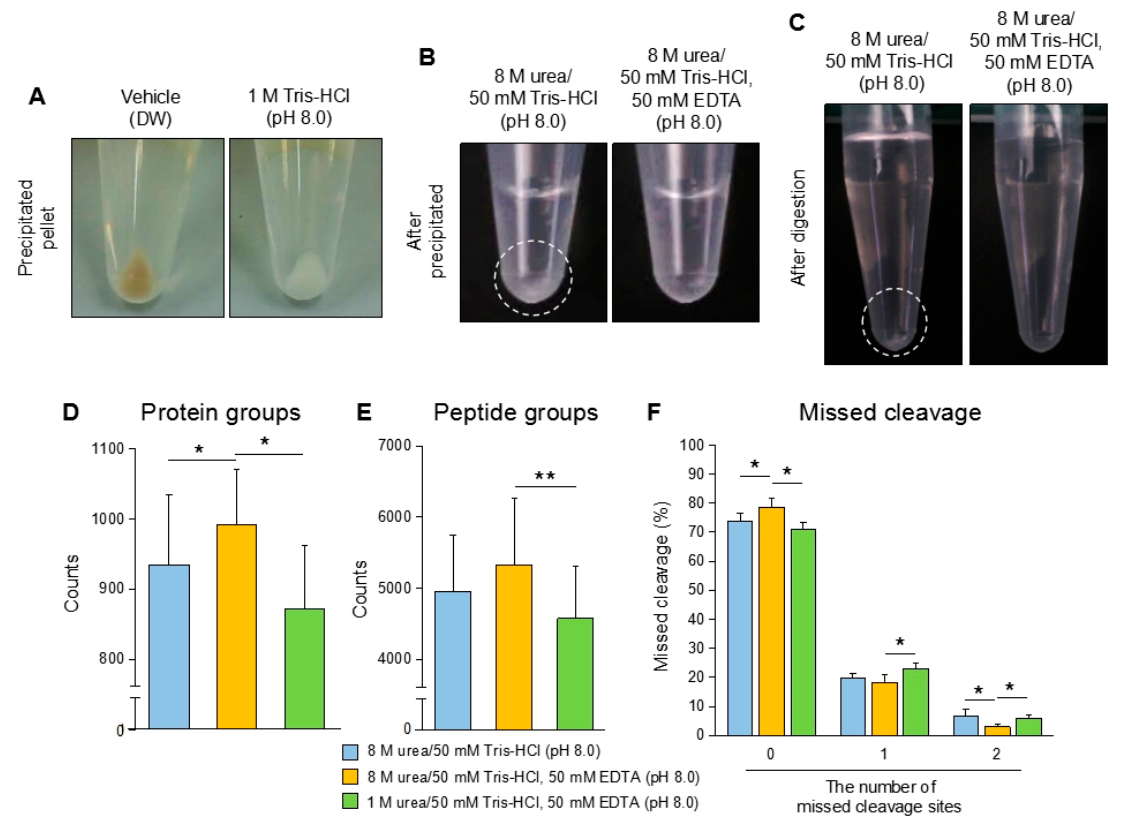
Figure 3. The additional applications in methanol / chloroform (M / C)-based urine protein precipitation. ( A ) Tris-HCl pre-treatment contribute to removing contaminants from precipitated urine protein. Crude urine was treated with 12.5 µ L (1 / 20 of volume) of 1 M Tris-HCl (pH 8.0) or vehicle control (DW), then the urine proteins were extracted by M / C precipitation. ( B ) The EDTA containing buffer enhances the dissolution of precipitated urine protein. The precipitated protein samples were dissolved in 8 M urea, 50 mM Tris-HCl, 50 mM EDTA buffer (pH 8.0) or 8 M urea, 50 mM Tris-HCl (pH 8.0), respectively. ( C ) The condition of the peptide solution after digestion with trypsin. Precipitated proteins in ( B ) were treated with trypsin. ( D – F ) The number of identified proteins in the samples treated with each buffer. The urine proteins extracted by M / C precipitation were dissolved in 8 M urea, 50 mM Tris-HCl (pH 8.0); 8 M urea, 50 mM Tris-HCl, 50 mM EDTA (pH 8.0); 1 M urea, 50 mM Tris-HCl, 50 mM EDTA (pH 8.0), respectively. The precipitated urine samples were treated with trypsin. The samples were analyzed by LC-MS / MS, and proteomic data were analyzed by Proteome discoverer 2.1. (A-C) Data are representative of at least three independent experiments. (D–F) The data are based on three urine samples originated from different health volunteers in each